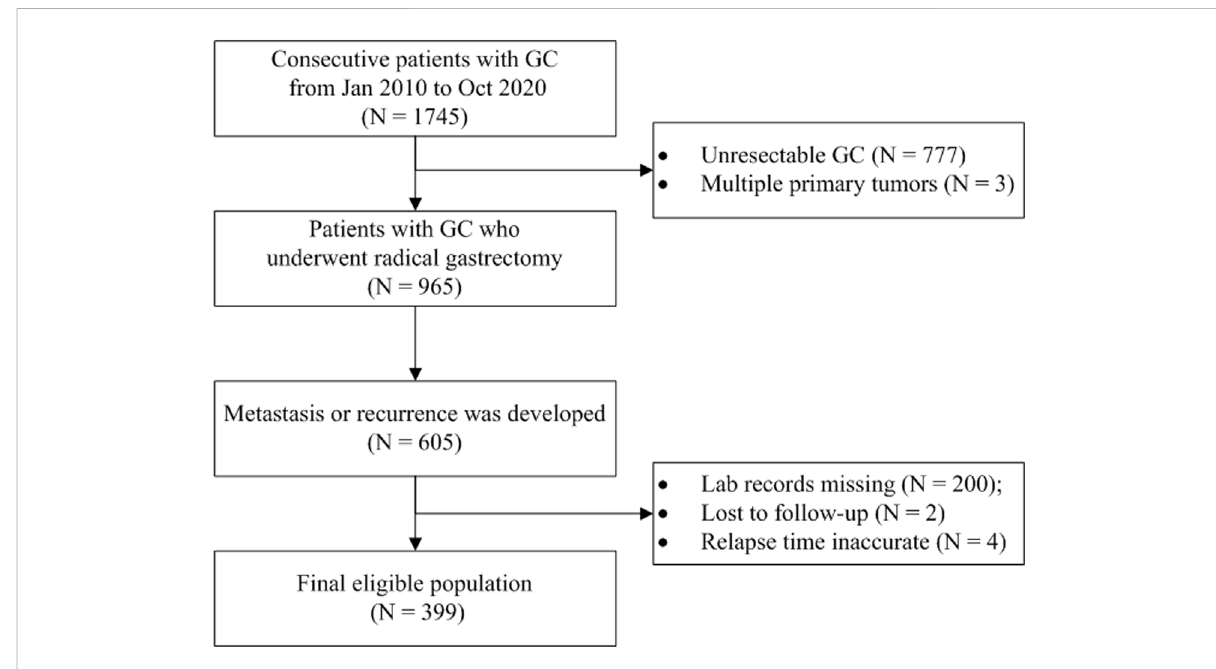
FIGURE 1 Flow diagram of patient selection. Abbreviation: GC, gastric